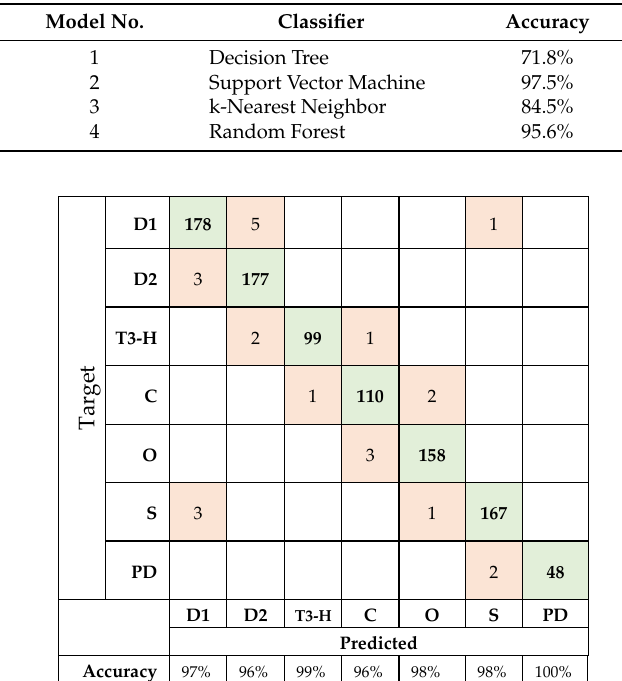
D2 Figure 4. Prediction results of SVM-based DPM.